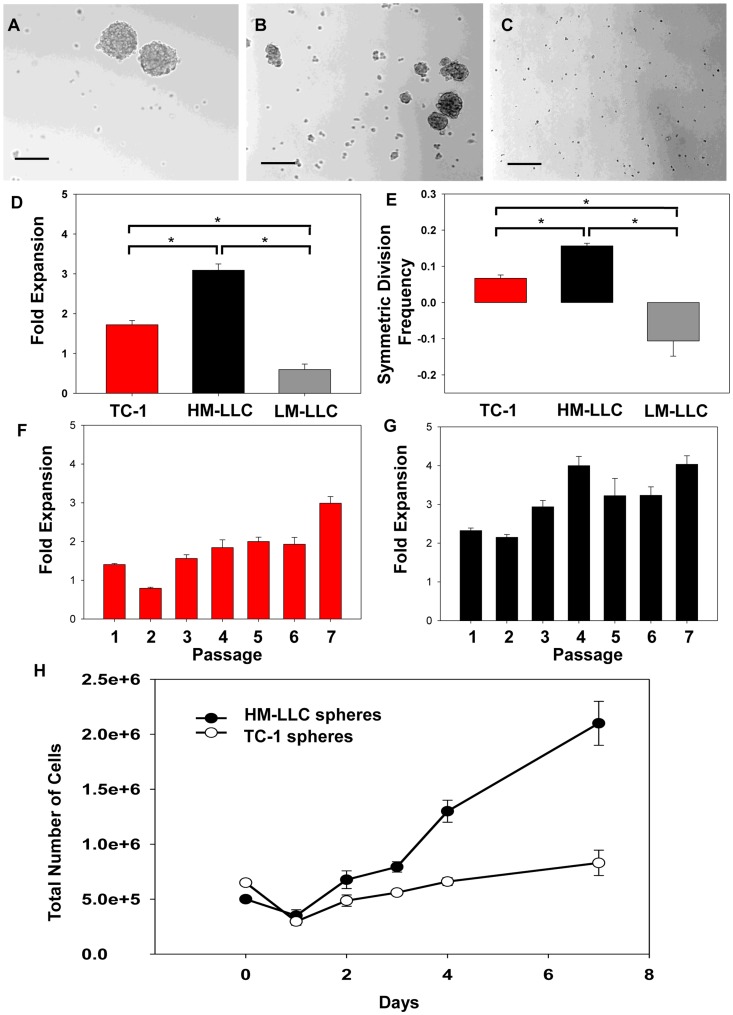

In vitro tumorsphere assays.Photomicrographs (10X) of passage 2 day 7 sphere cultures of (A) TC-1 spheres, (B) HM-LLC spheres and (C) LM-LLC sphere media culture. Bar = 100 µm. (D) Total fold expansion and (E) symmetric division frequency over eight passages for TC-1 spheres (red) and HM-LLC spheres (black), and two passages for LM-LLC sphere media culture (grey) shows significant differences; *P<0.001. (F–G) Fold expansion over seven passages for TC-1 spheres (red) and HM-LLC spheres (black). (H) Passage 2 spheres were cultured and counted for total number of cells on the days as shown. Experiment repeated twice, representative results shown. On day 1 the total number of cells in culture is reduced. The surviving mitogen-responsive cancer initiating cells are responsible for cell proliferation and generating fresh multi-cellular spheres that can be harvested on day 7. Bars: ±Standard error of the mean (SEM).